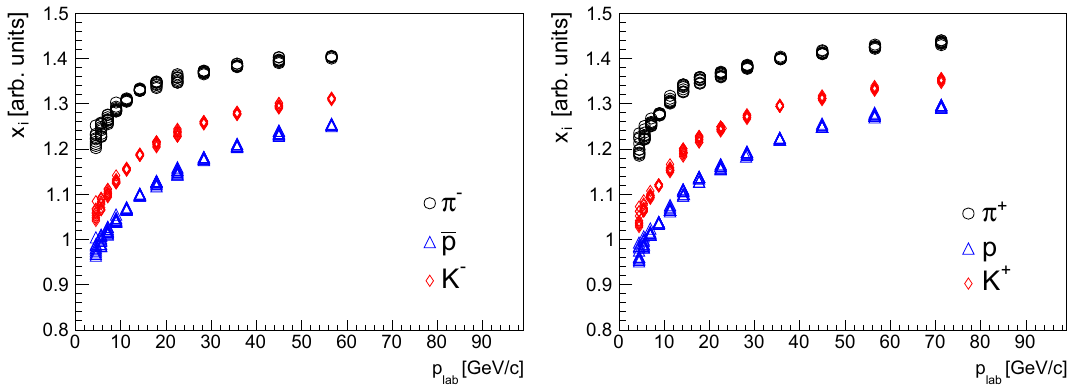
Fig. 6 Fitted peak positions in p + p interactions at 158 GeV / c for different particles as a function of p lab . Different points at the same value of p lab correspond to different transverse momentum